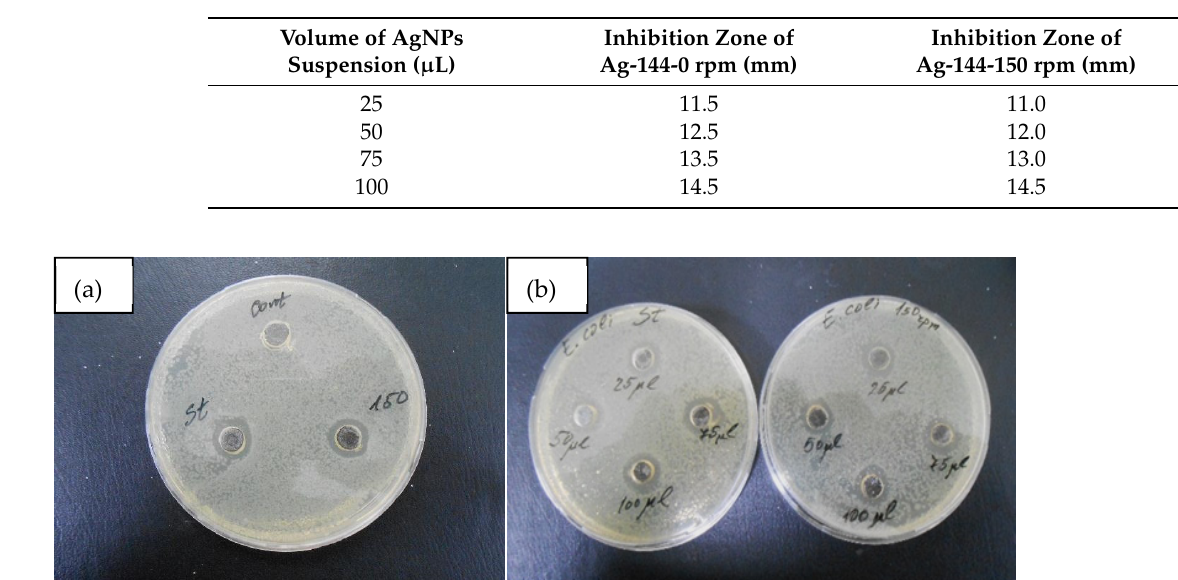
Figure 12. Inhibition zones of the AgNPs obtained by biotransformation under static and dynamic conditions, with respect to E. coli strain 3398: ( a ) 50 µL suspension of Ag-144-0 rpm (on the left) and Ag-144-150 rpm (on the right) with distilled water used as control; ( b ) 25, 50, 75 and 100 µL suspension of Ag-144-0 rpm (in the left Petri dish) and Ag-144-150 rpm (in the right Petri dish). Table 4. Inhibition zones of the AgNPs (25, 50, 75 and 100 µL suspensions) obtained by biotransformation under static (Ag-144-0 rpm) and dynamic (Ag-144-150 rpm) conditions, with respect to E. coli strain 3398.